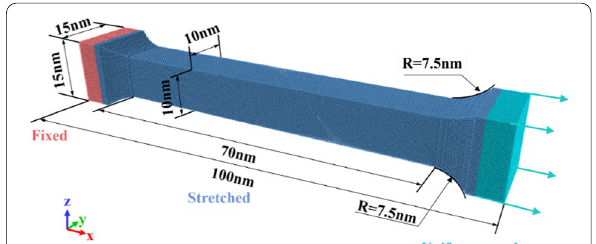
Fig. 1 Nano-stretching model of single crystal copper